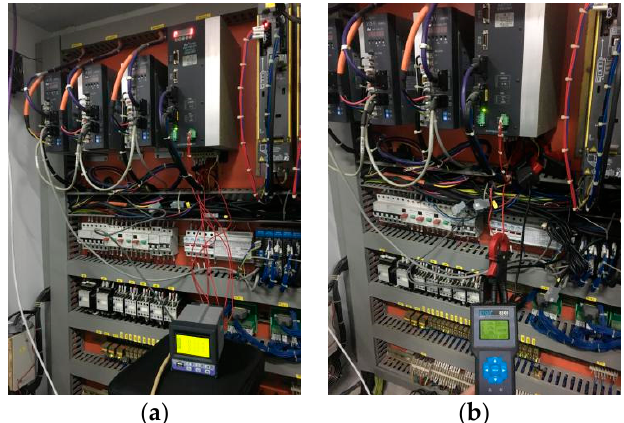
Figure 4. Power detection equipment. ( a ) shows the connection of the power recorder, ( b ) shows the connection of the current monitoring device.